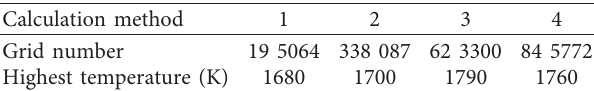
Table 2: Results of the highest temperature of the outlet dependent on different grid densities.